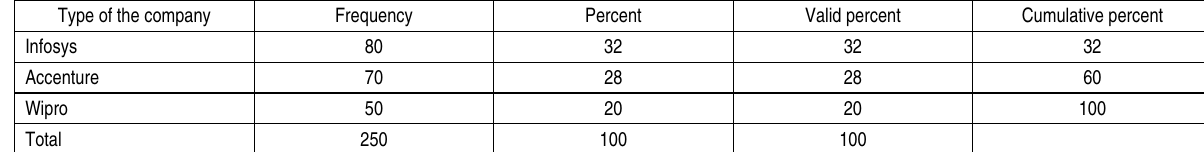
Table 5. Frequency and percentage of employees with respect to type of company